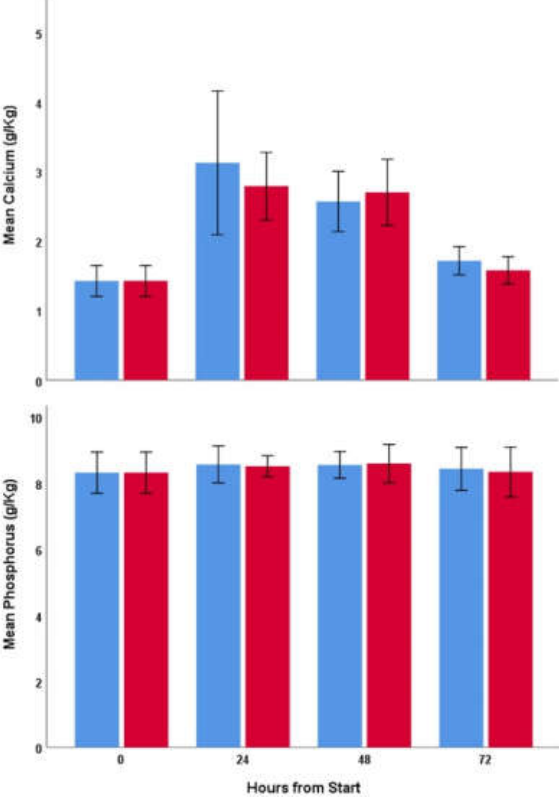
Figure 1. Mean calcium (top) and phosphorus (bottom) content of crickets at each sampling point. Blue bars indicate UVB irradiated crickets, while red bars indicate control crickets.